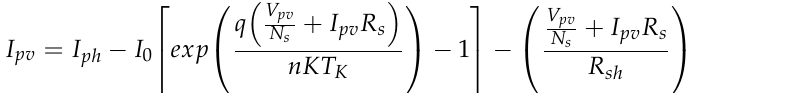
Figure 9. Single-diode model PV cell equivalent circuit. Figure 9 . Single-diode model PV cell equivalent circuit .